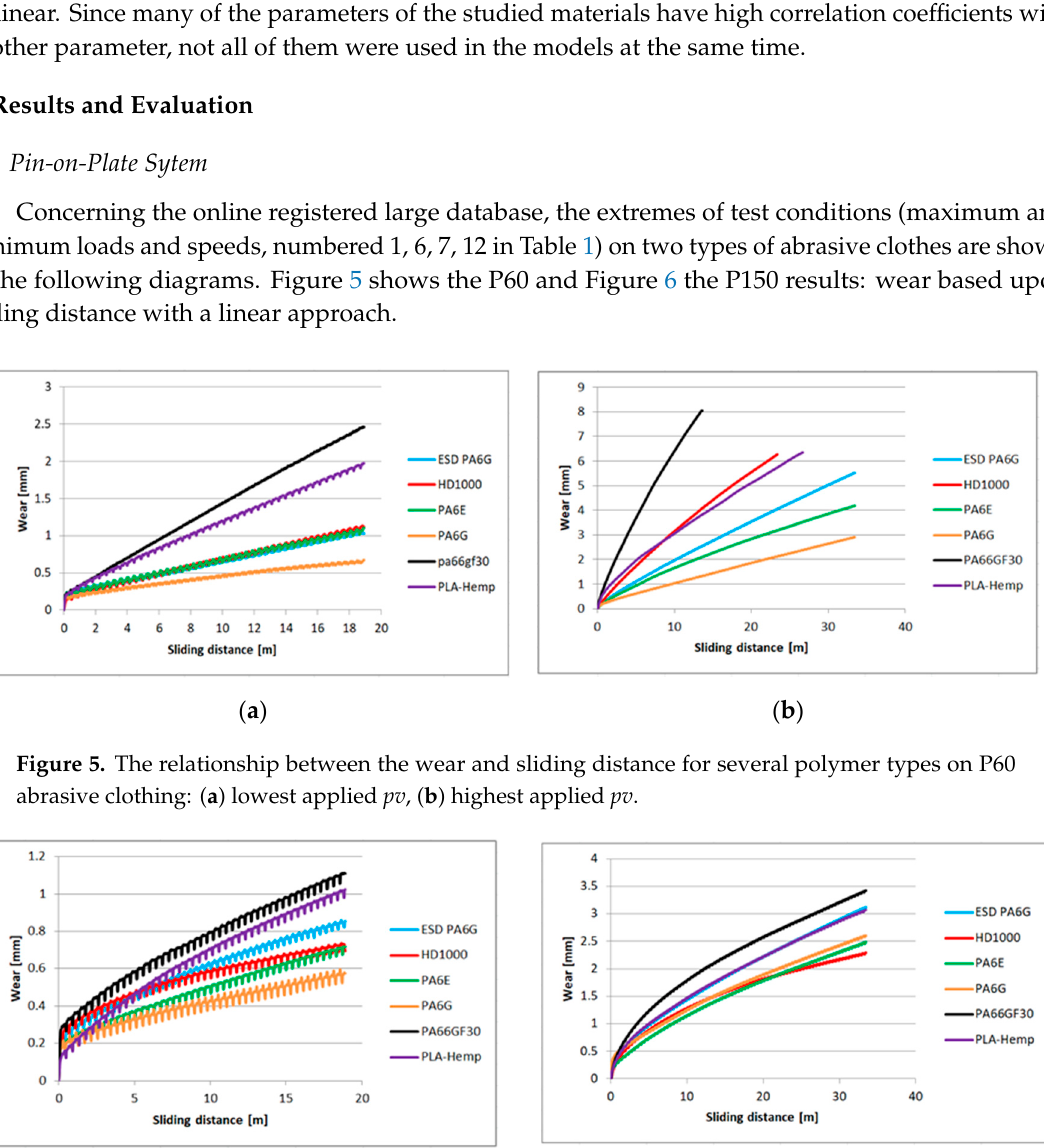
Table 4. The slope values (speed of wear) of linear regression in all the 12 test conditions. Material